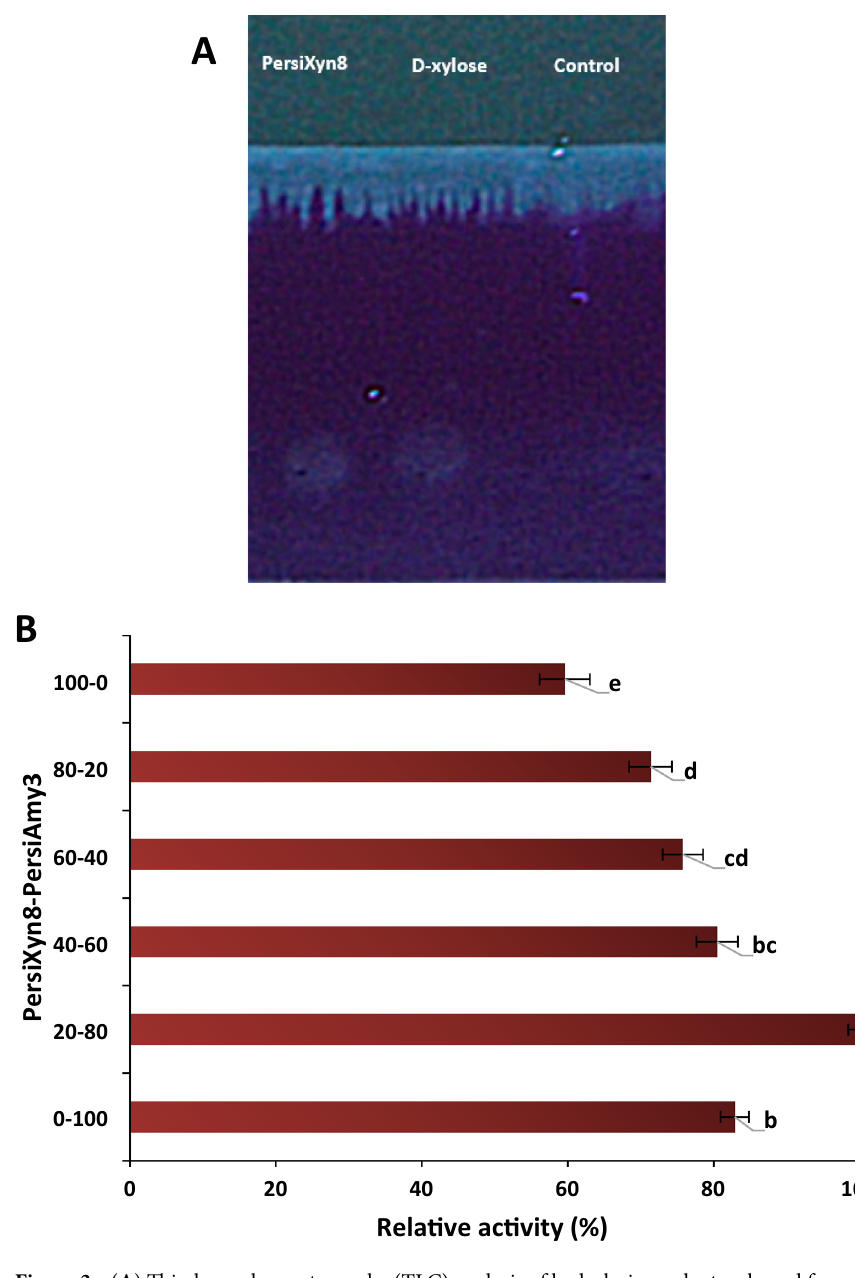
Figure 3. ( A ) Thin layer chromatography (TLC) analysis of hydrolysis products released from beech wood xylan by purified PersiXyn8, unhydrolyzed xylan was used as control. ( B ) Synergistic relationship between PersiXyn8 and PersiAmy3. Means with different letters are significantly different (p <